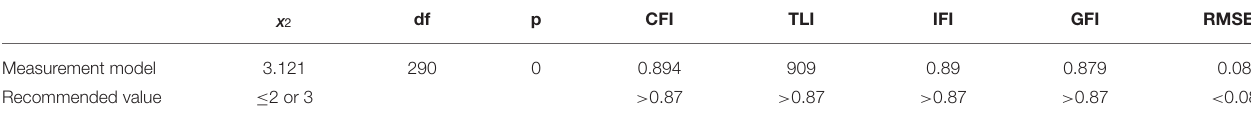
TABLE 4 | The root mean square error of approximation and the CFA results.